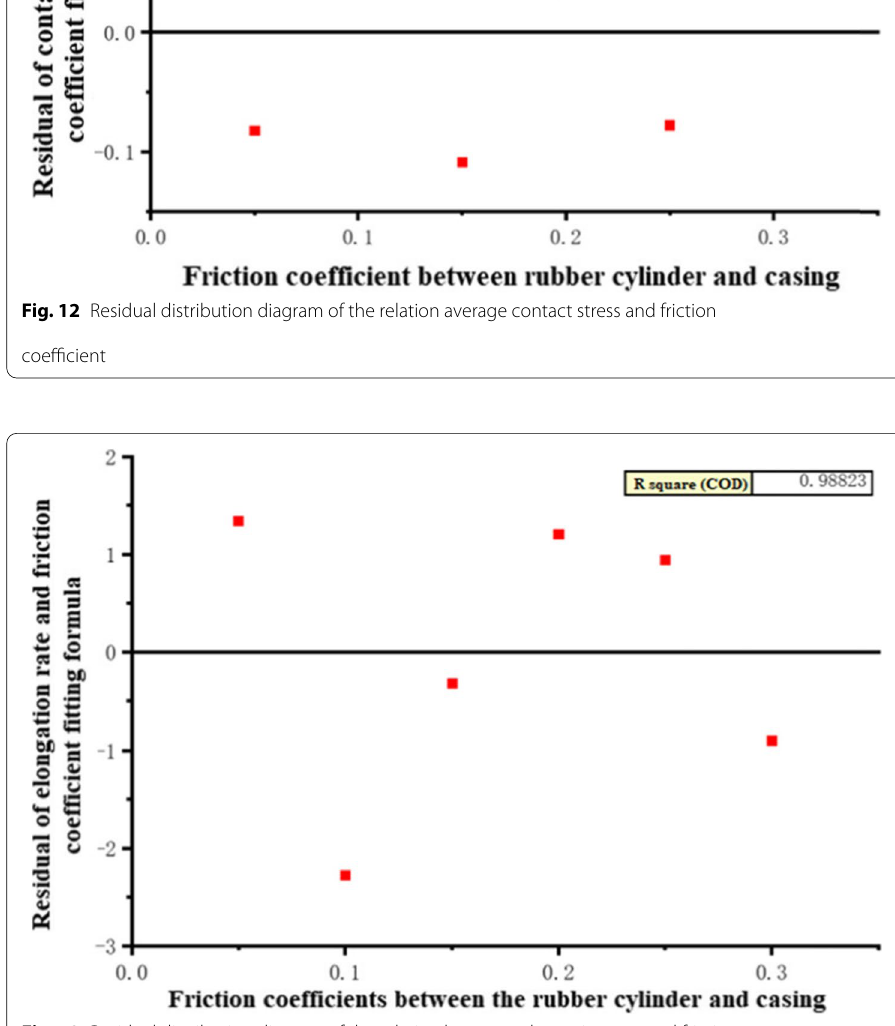
Fig. 13 Residual distribution diagram of the relation between elongation rate and friction